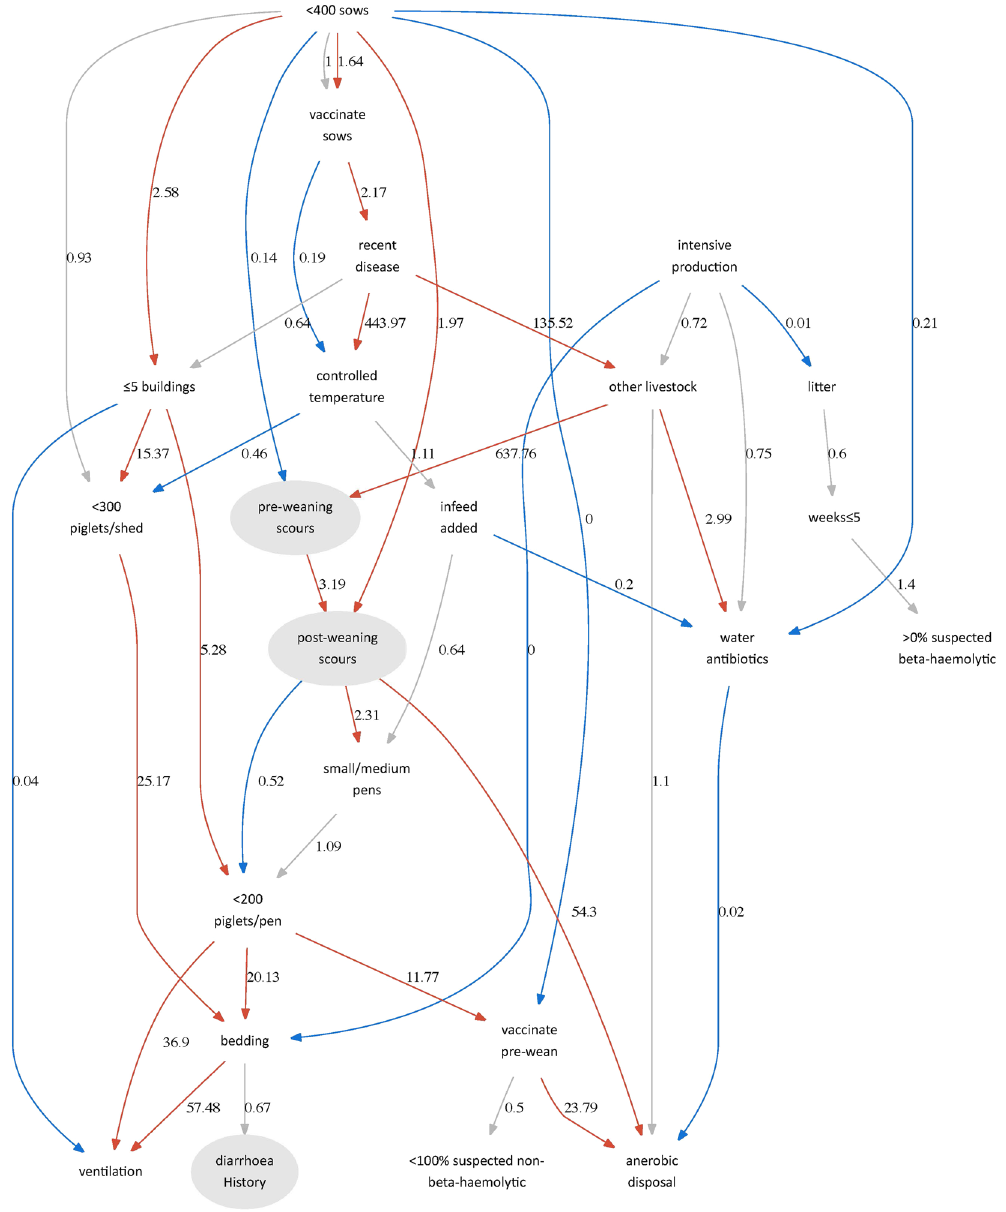
Figure 1. Additive Bayesian Network showing odds ratios of observing each a given value of a node conditional on the network. The three diarrhoeal variables are highlighted in grey. In this figure, the network includes fixed effects only having identified the structure via non-parametric bootstrapping and a tabu modified greedy hill- climbing search for the optimal structure. Red arcs indicate positive associations that do not include 0 in the 95% credibility interval; blue arcs are negative associations that no not include 0 in the 95% credibility interval; the 95% credibility interval of grey arcs include